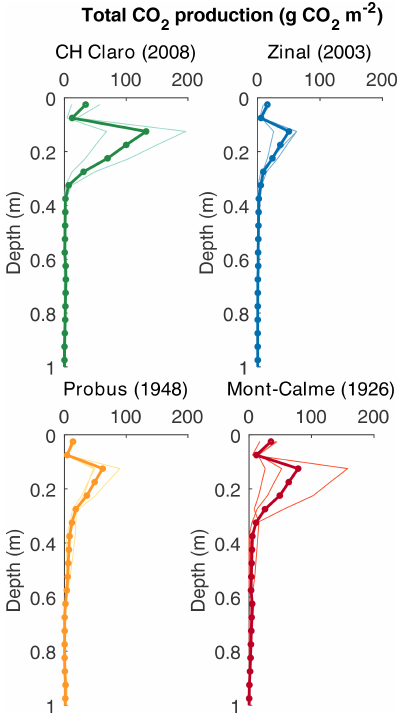
Figure 6. Depth profiles of calculated cumulative CO 2 production (gCO 2 m − 2 per 0.05m depth layer). Dots show the calculated pro- duction rates, thin lines show the calculated CO 2 production for the individual lysimeters and the thick lines show the average based on three replicates (two for CH